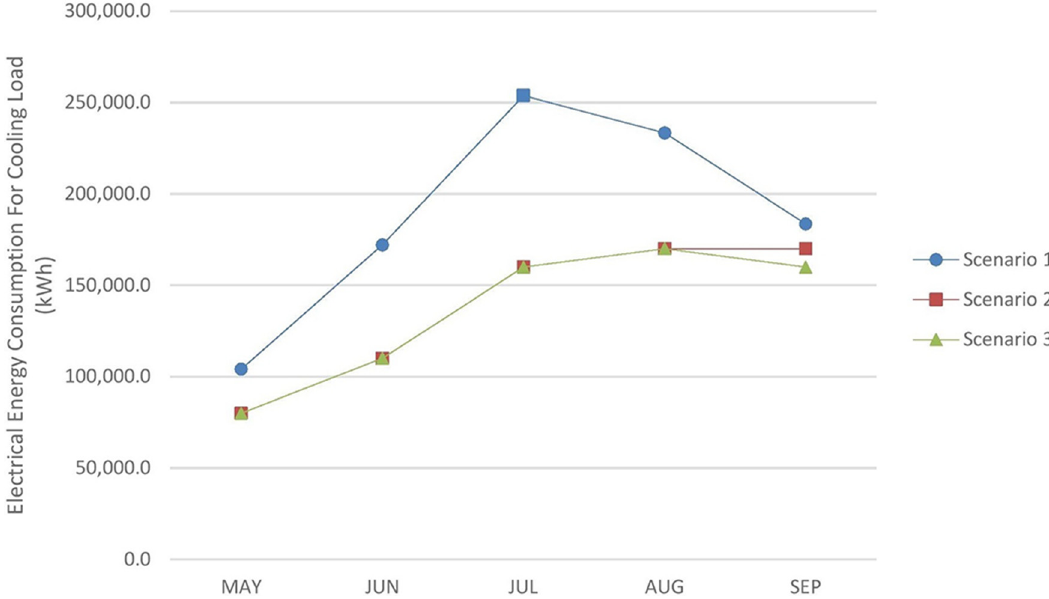
Fig. 10. Cooling load electrical energy consumption for screw chillers.